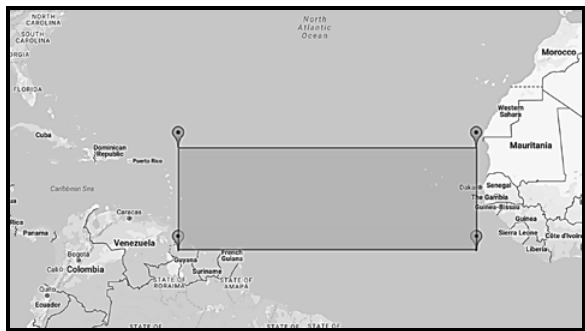
Figure 1. The Atlantic Tropical Cyclogenesis Region (ACR), bounded in latitude between 6° - 18° N, and in longitude between 20° - 60° W. According to the SSHWS scale, between 1,566 recorded events in the ACR from 1886 to 2017, 734 storms have hurricane intensity, and 590 storms have TC intensity (Table